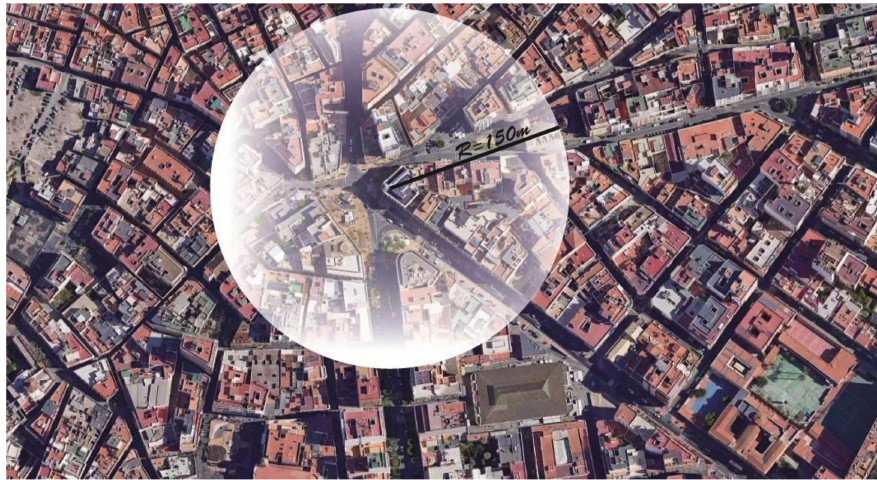
Figure 4. Aerial view of the area around Casa de las Mariposas in Almer í a. Source: Own elaboration.